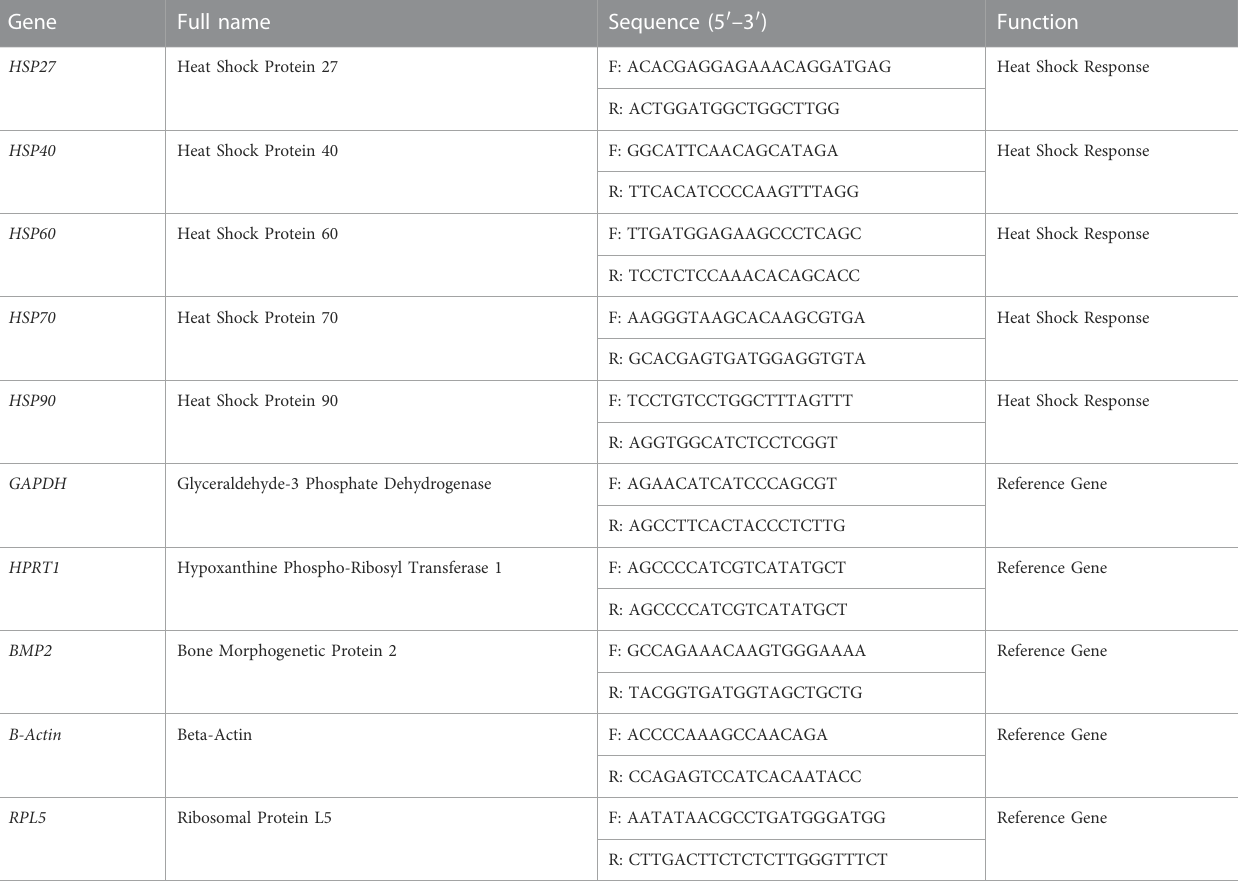
TABLE 1 Description of all primers related to Gallus gallus HSP genes and the reference genes used for RT-qPCR analysis.